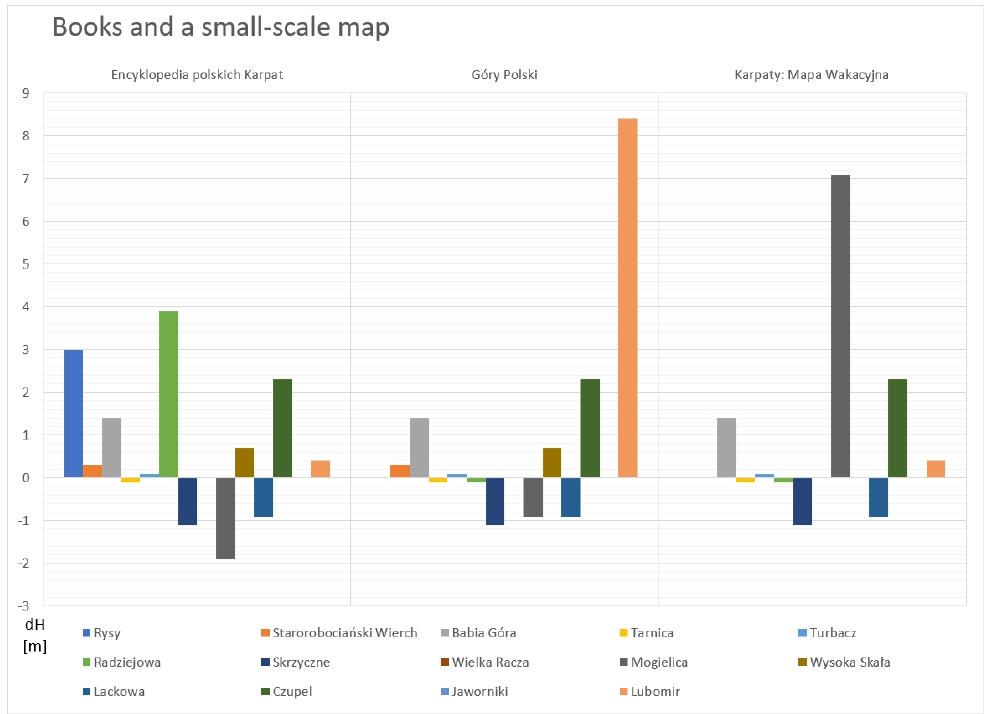
Figure A6. Height difference with GNSS surveying for book and small-scale map sources. Source: authors.